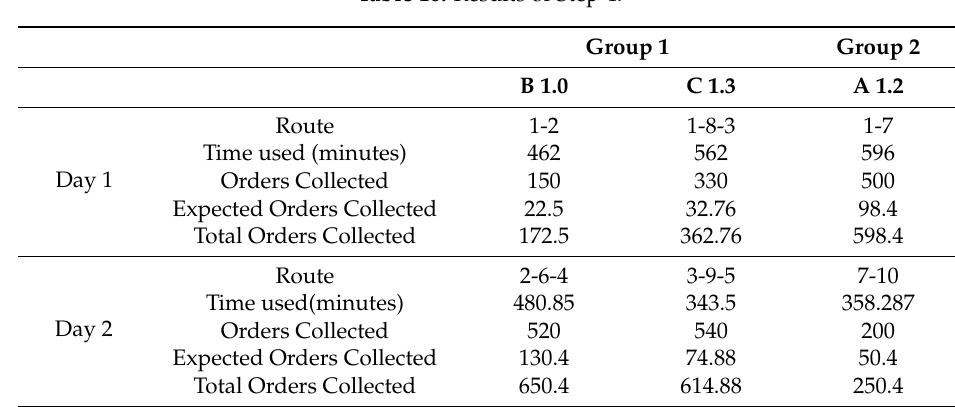
Figure 7. The decoding procedure. Table 10. Results of Step 4.